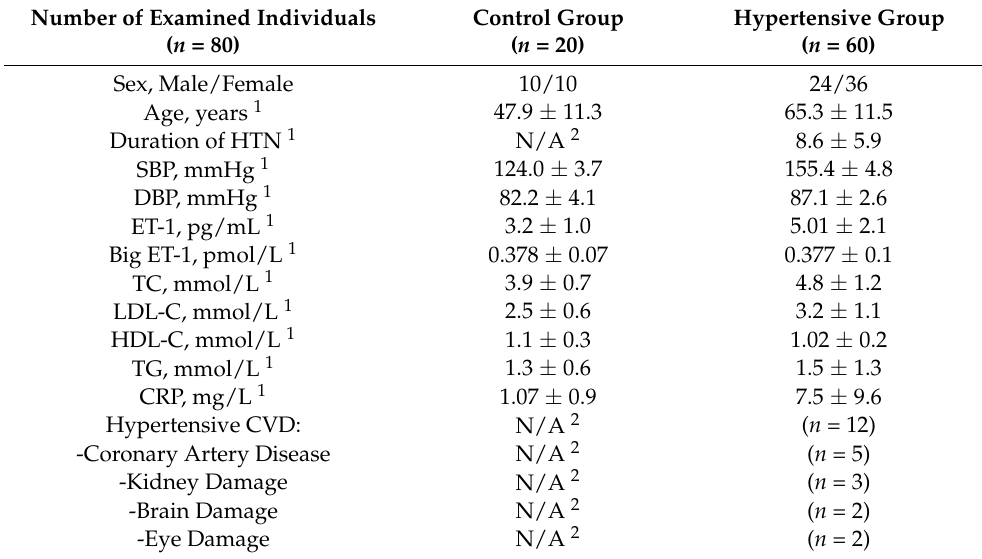
Table 1. Clinical characteristics of the